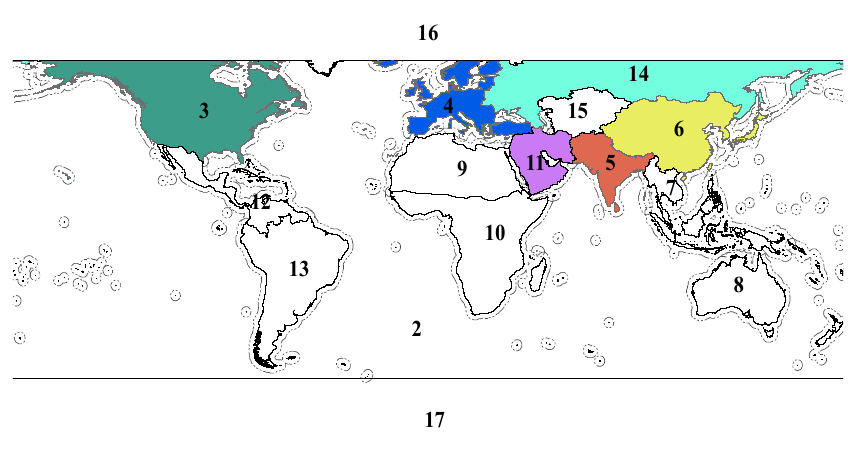
Figure 1. Boundaries of regions and coastal areas (dashed). Six regions with perturbation experiments: 3 – North America (NA), 4 – Europe (EU), 5 – South Asia (SA), 6 – East Asia (EA), 11 – Middle East (ME) and 14 – Russia, Belarus, and Ukraine (RU). Others: 1 – Global, 2 – Ocean, 7 – Southeast Asia, 8 – Australia, 9 – North Africa, 10 – Sub-Saharan Africa, 12 – Mexico, Central America, the Caribbean,